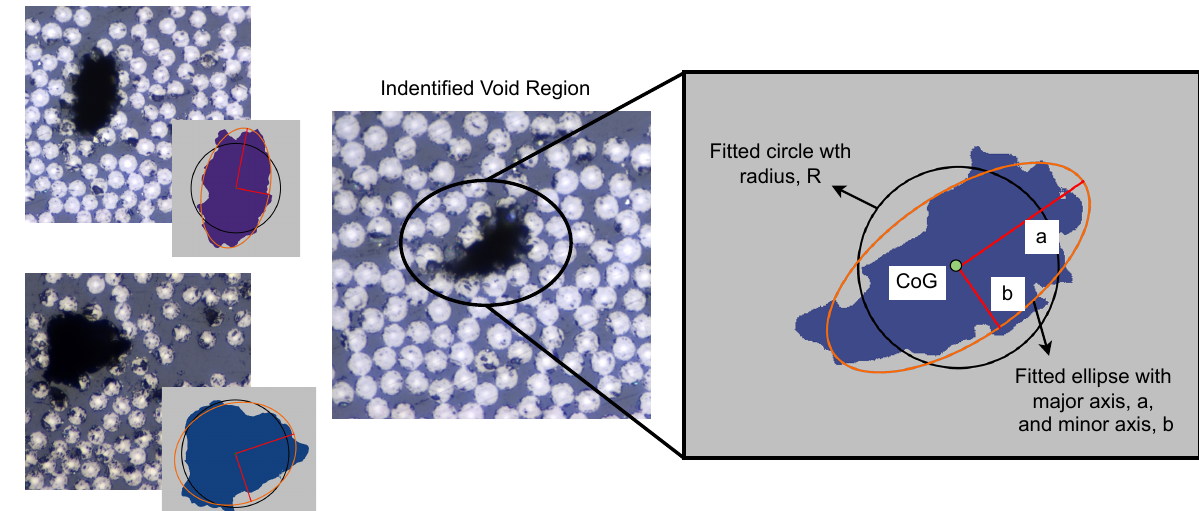
Figure 5. Identified void regions with the void fitted to a circular and an elliptical